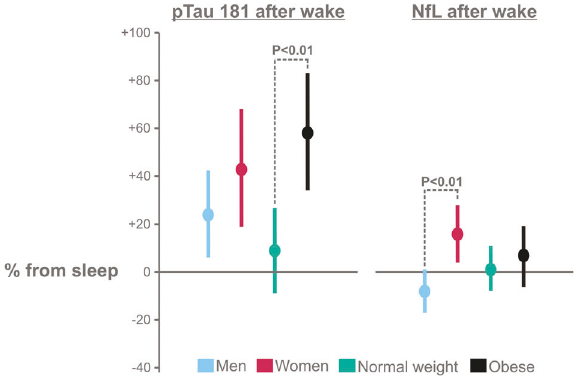
Fig. 5 Morning blood concentrations of the CNS health biomar- kers NfL and pTau181 after sleep loss expressed as fold change from blood concentrations measured after sleep. Values are shown as estimated marginal means [95%-CI] as derived from general linear models. P < 0.05 was considered signi fi cant. pTau Tau protein, NfL neuro fi lament light